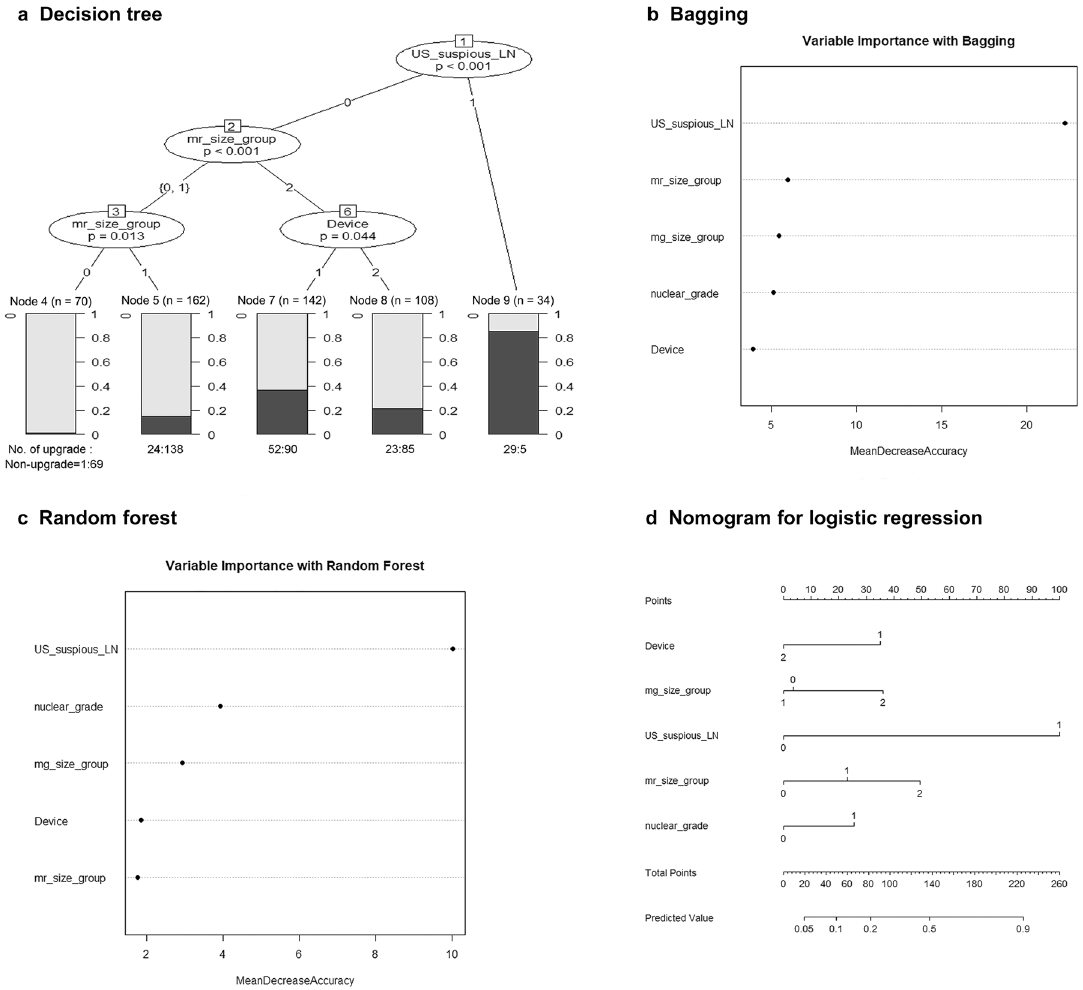
Fig. 3 Variable importance graphs of the most important risk factors in descending order and nomogram. a decision tree, b bagging, and c random forest-based machine learning methods and d a nomogram for the logistic regression